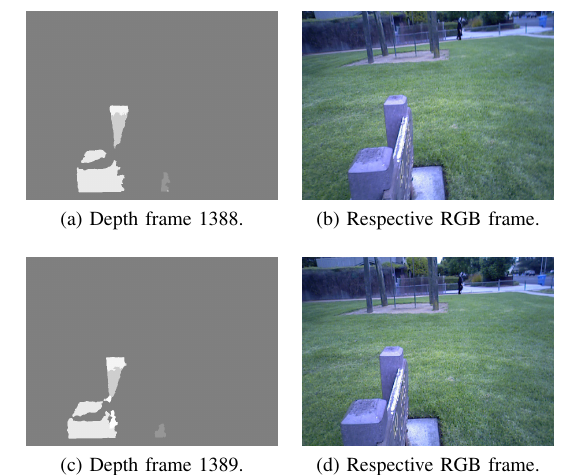
Fig. 14: A pair of depth frames (14a, 14c) and their respective RGB frames (14b, 14d). Note the small area in the depth frames that the sensor was able to capture, yielding fewer points than those of Figure 4a, 4b and 4c, in comparison.